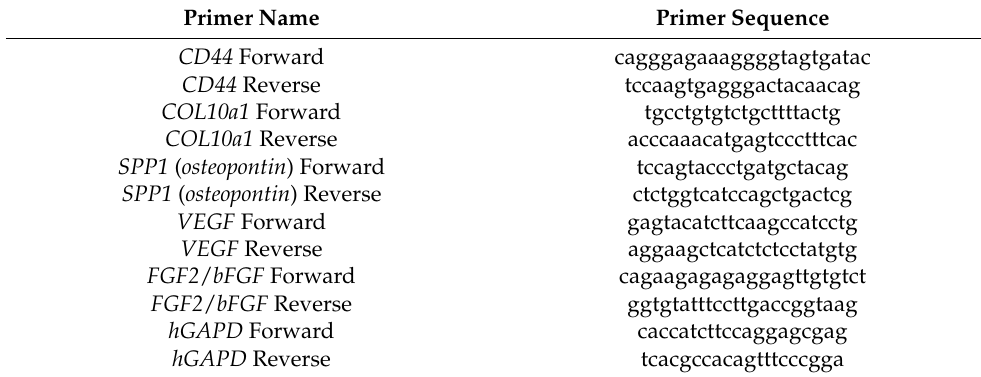
Table 2. Real-time PCR